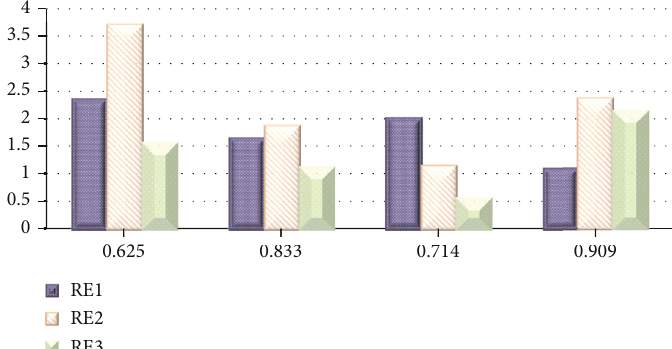
, m = ð 4, 3 Þ . 1 2 Þ